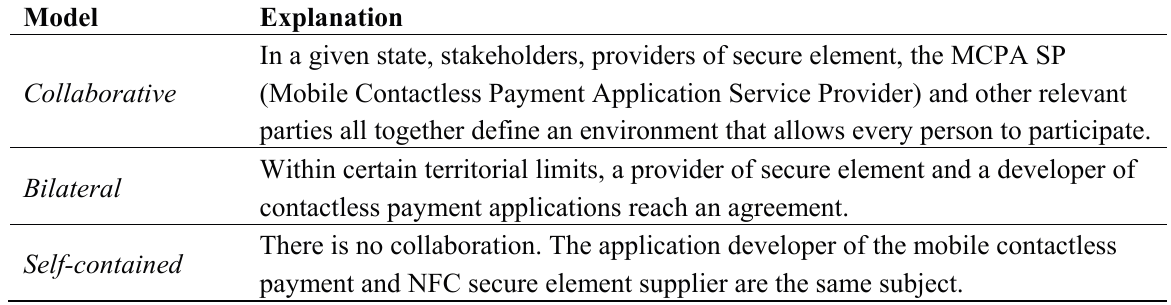
Table 1. Three models on how service providers can cooperate with other stakeholders to get into the market (source: authors’ elaboration based on